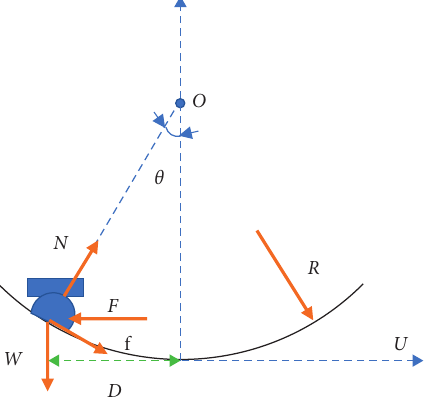
Figure 2: Calculation model of FPS.